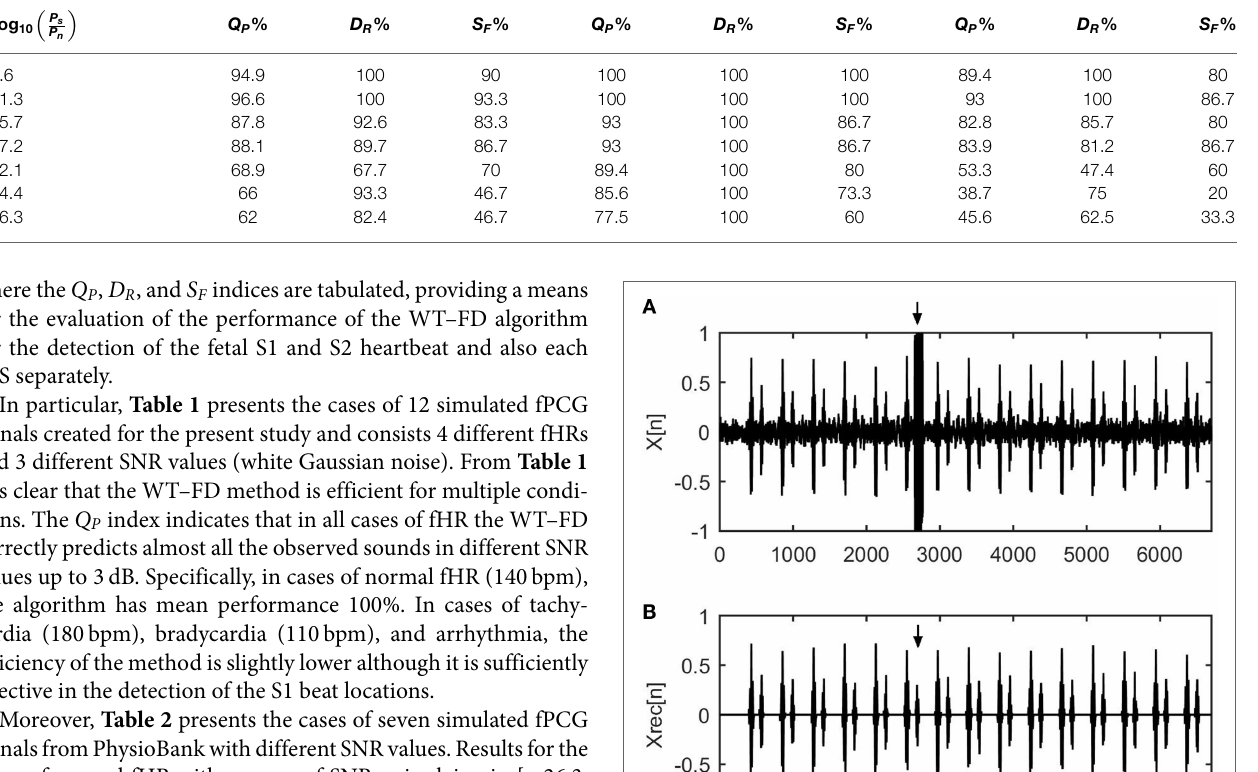
mount the piezo sensor. Each sensor picks fPCG signals through a coaxial cable having very high insulating resistance. Power lab data acquisition system by AD instrument 2 was used to record the abdominal phonograms at a sampling frequency of f s = 1,000 Hz. A characteristic example of one channel fPCG recording (time section of 3 s) with maternal heart rate of 96 bpm and fHR of 145 bpm is shown in Figure 4A . From the latter, it is clear that the